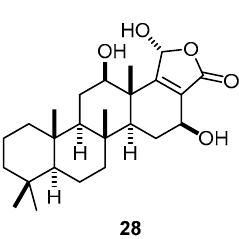
Figure 8. Chemical structure of sesterstatin 6 ( 28 ).